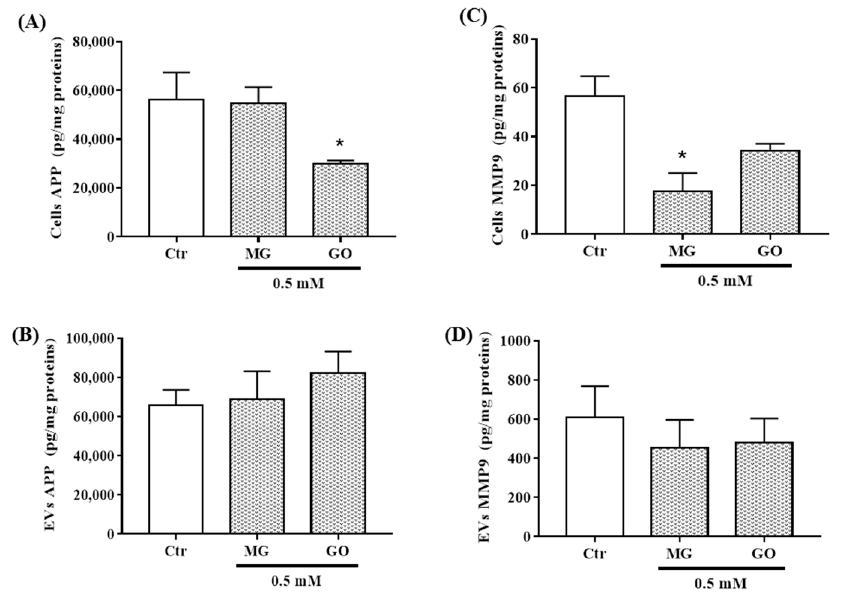
Figure 6. APP and MMP9 levels in nEVs and in SK-N-SH exposed or not to MG and GO. The level of each marker was normalized using total protein concentration. The bar graphs show APP and MMP9 levels in SK-N-SH cells ( A , C ) and in nEVs ( B , D ). Values are mean ± S.E.M (from three separate experiments) and data groups were compared with one-way ANOVA followed by the Dunnett’s post hoc test. * p < 0.05 versus control cells.